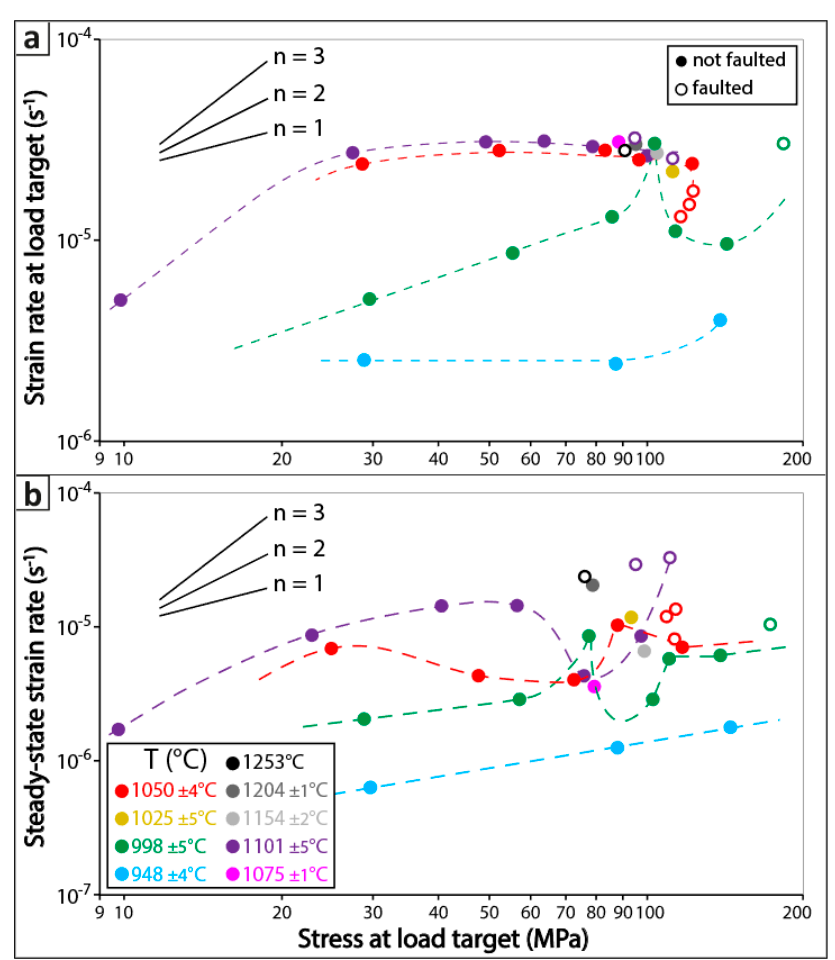
Figure 9. Results of creep tests. ( a ) Strain rate right after the load target is reached; ( b ) Strain rate once the secondary creep reaches a steady state. Solid and open circles account, respectively, for samples that deformed homogeneously until the end of the experiment and samples in which tertiary creep (cavitation) eventually lead to macroscopic faulting. Stress exponents are indicated for comparison with other diffusion- and dislocation-dominated deformation mechanisms (see text). The Temperature variation during each experiment is lower than 5 °C.